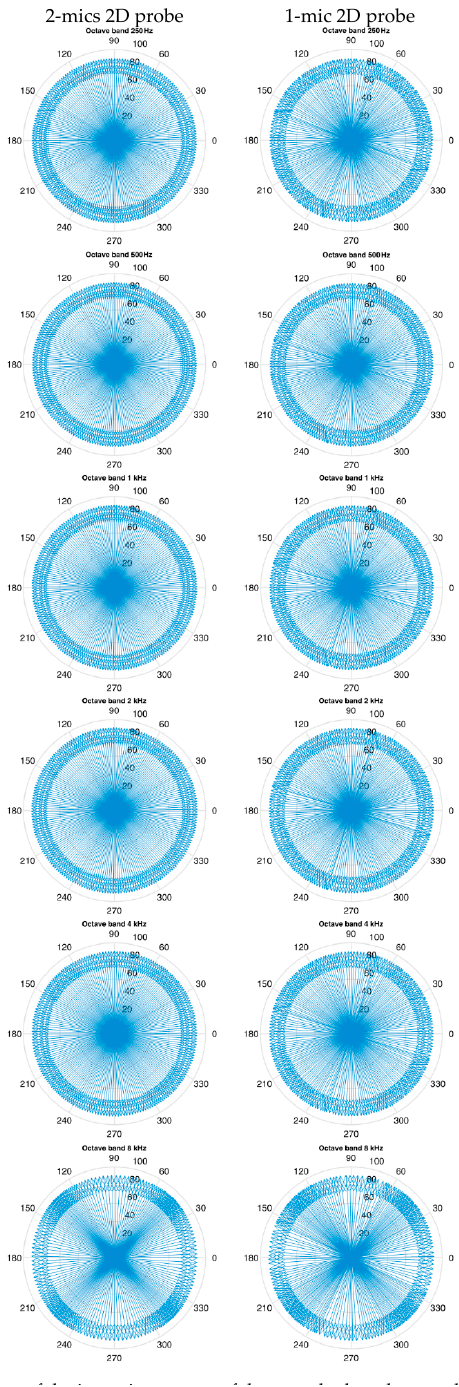
Figure 6. The distribution of the intensity vectors of the sound when the angular position of the probe relative to the sound source is incrementally changed for the octave bands from 250 Hz to 8 kHz.